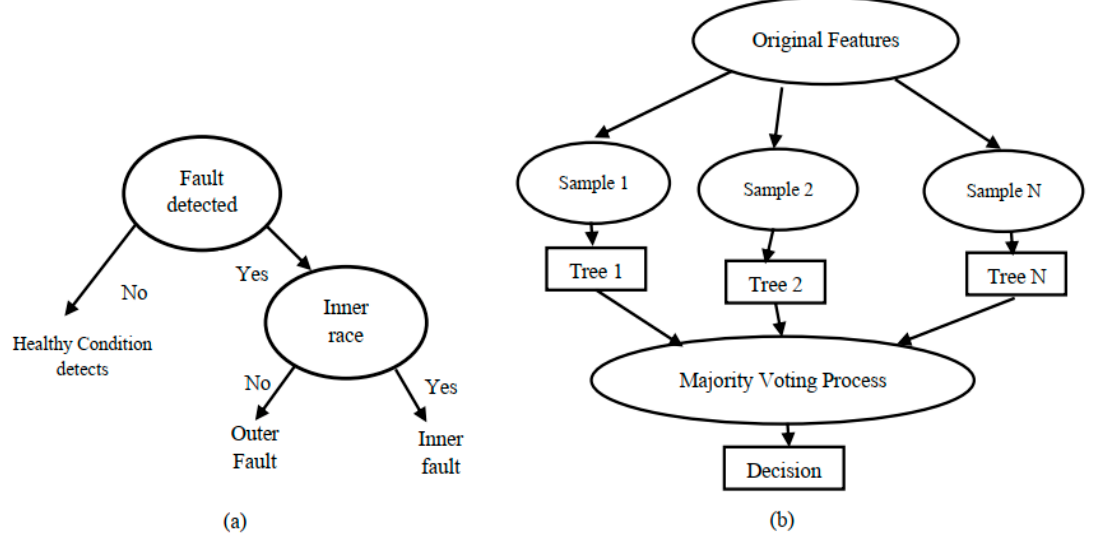
Figure 7. ( a ) Decision tree; ( b ) random forest architecture.